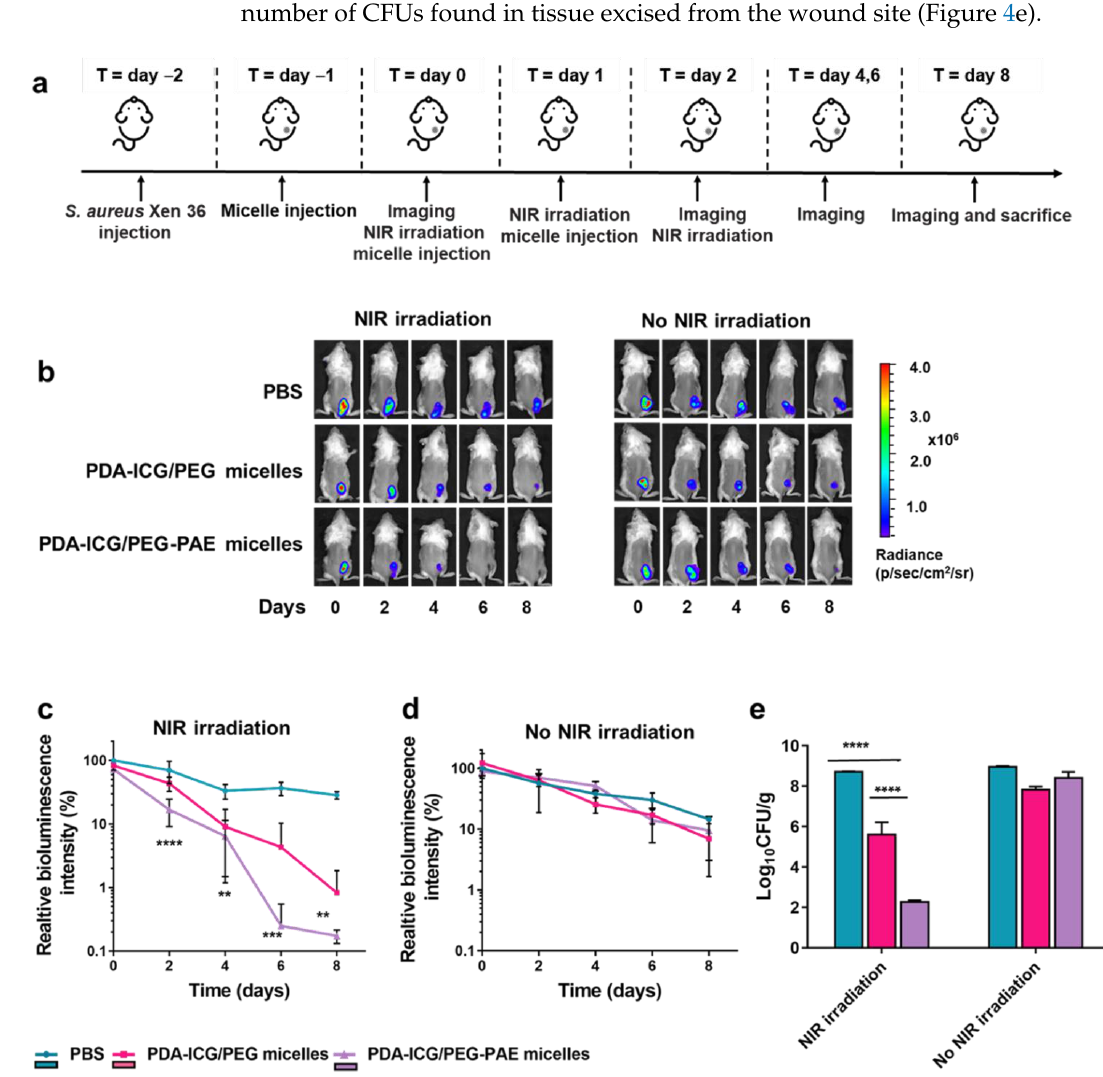
Figure 4. Eradication of a sub-cutaneous S. aureus Xen36 biofilm in mice after tail-vein injection of photothermal PDA- ICG-NPs encapsulated in micelles and in absence and presence of NIR irradiation. ( a ) Experimental scheme. ( b ) Time series of bioluminescence images of mice taken after injection of PBS (200 µL) or a suspension of micellar encapsulated photothermal nanoparticles in PBS (1 mg/mL) in absence or presence of NIR irradiation. ( c ) Bioluminescence intensity arising from the infection sites as a function of time after initiating injection and NIR irradiation. Bioluminescence intensity was expressed in percentages relating to the bioluminescence intensity at t = 0. ( d ) Same as panel c, now in absence of NIR irradiation. ( e ) Numbers of CFU/g tissue excised from around the infection site at sacrifice. Data represent means with standard deviations over 6 mice in each group. * indicate statistically significant differences between the data indicated by the spanning bars (one-way ANOVA; ** p < 0.01, *** p < 0.001, **** p < 0.0001).